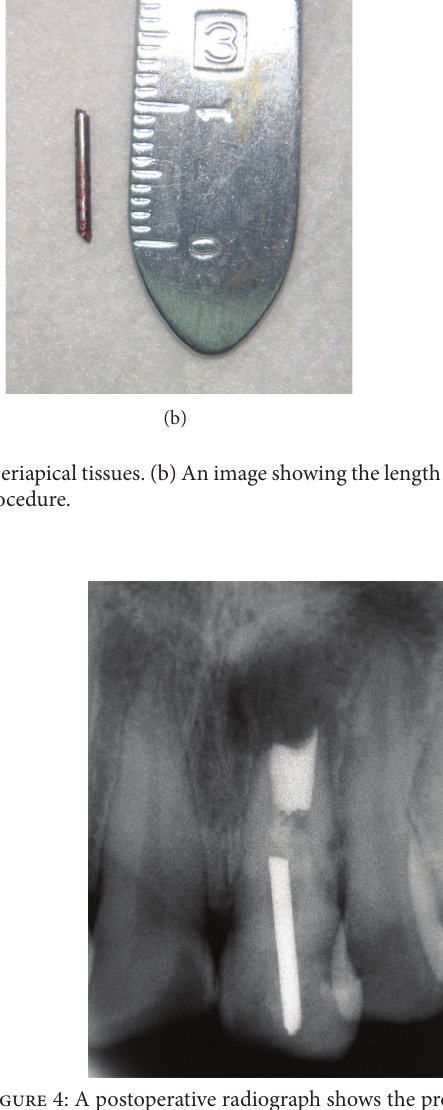
Figure 3: Clinical appearance of the surgical socket after the removal of the metal fragment.